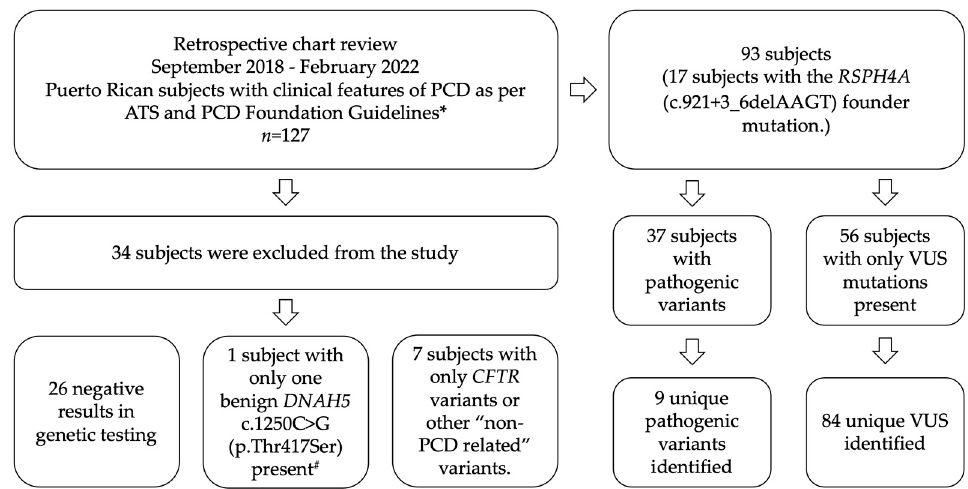
Figure 1. Diagram of inclusion and exclusion criteria. * Subjects with pathogenic variants or VUS in PCD genes were included in the study. # DNAH5 c.1250C > G (p.Thr417Ser) benign variant was excluded.